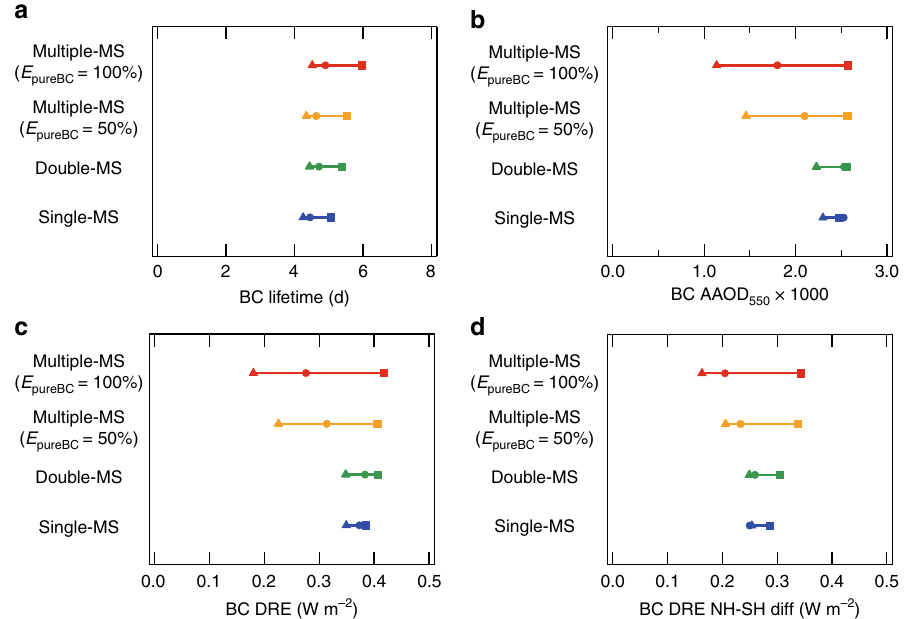
Fig. 1 Sensitivity of black carbon properties to emission size distributions. The maximum-minimum ranges for a black carbon (BC) lifetime, b BC absorption aerosol optical depth at 550 nm (AAOD 550 ), c BC direct radiative effect (DRE), and d the contrast of BC DRE between the Northern and Southern Hemispheres. Squares, circles, and triangles show the values in the Small-size, Base-size, and Large-size simulations,